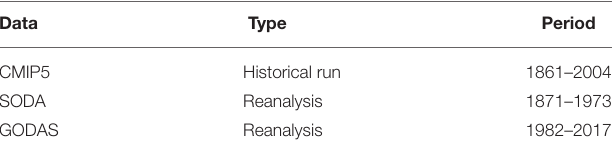
TABLE 1 | The dataset for training and testing the model.